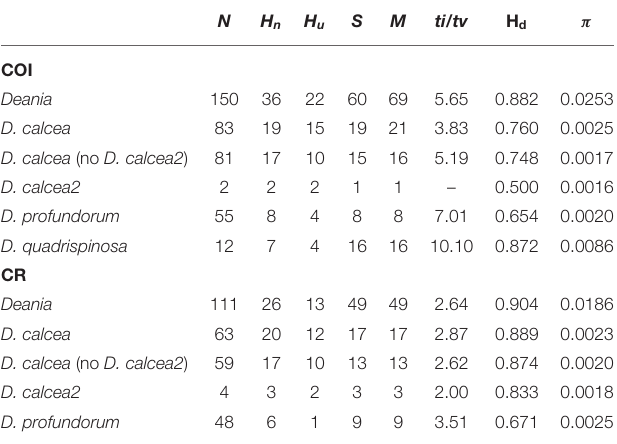
TABLE 2 | Summary statistics for COI and CR.